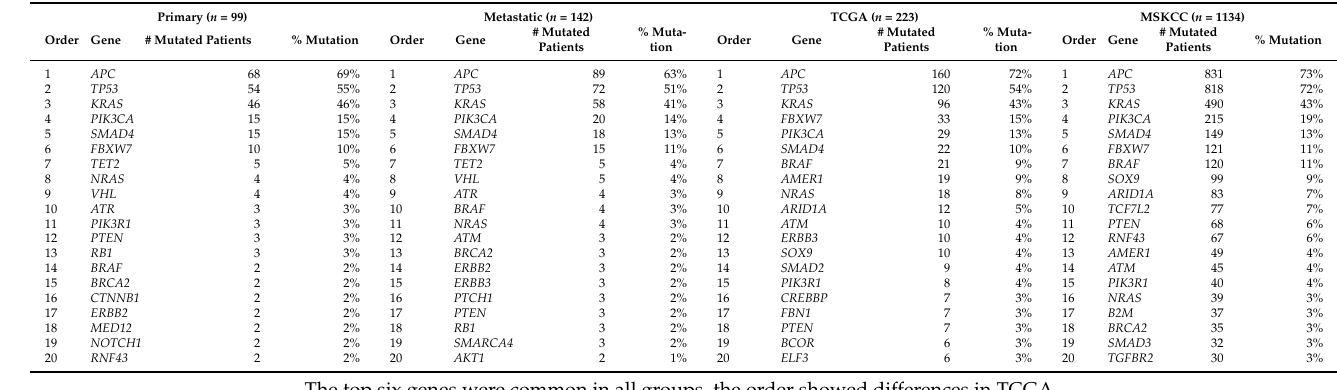
Table 4. Top 20 frequently mutated genes in 4 groups.